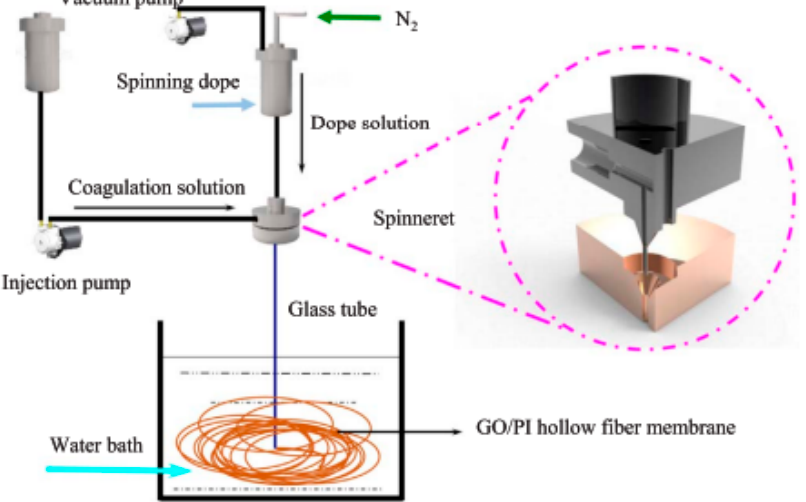
Figure 6. Schematic of the preparation of GO-PI hollow fiber membranes by direct spinning. Reprinted with permission from Ref. [274]. Copyright 2018 Aisheng Huang et al.